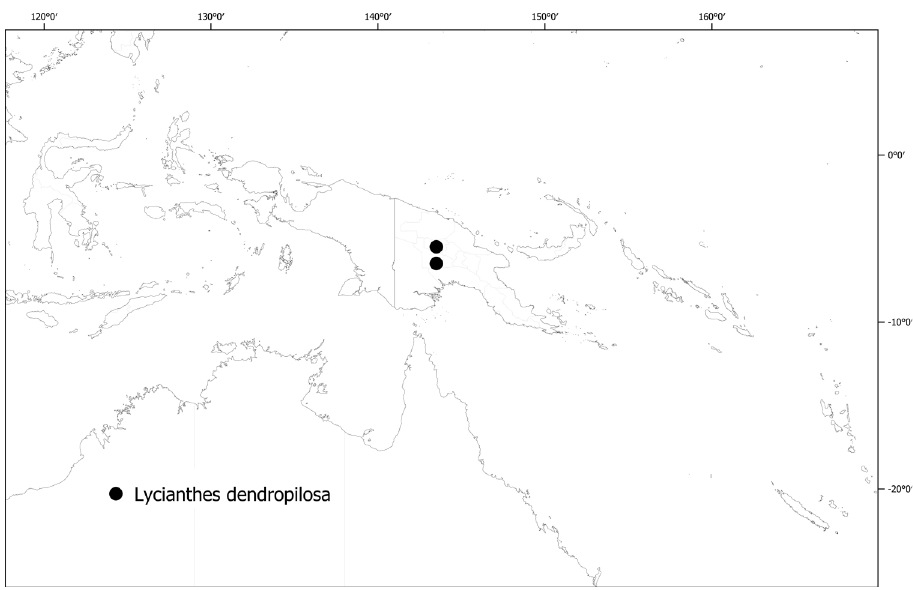
Figure 21. Distribution of Lycianthes dendropilosa